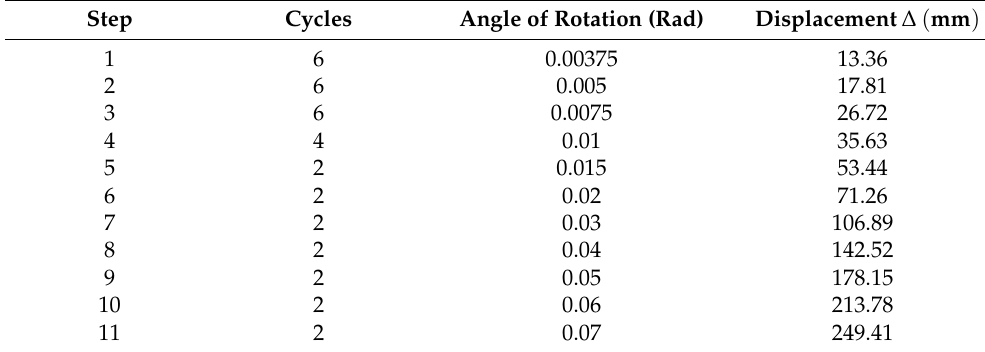
Table 2. Displacement